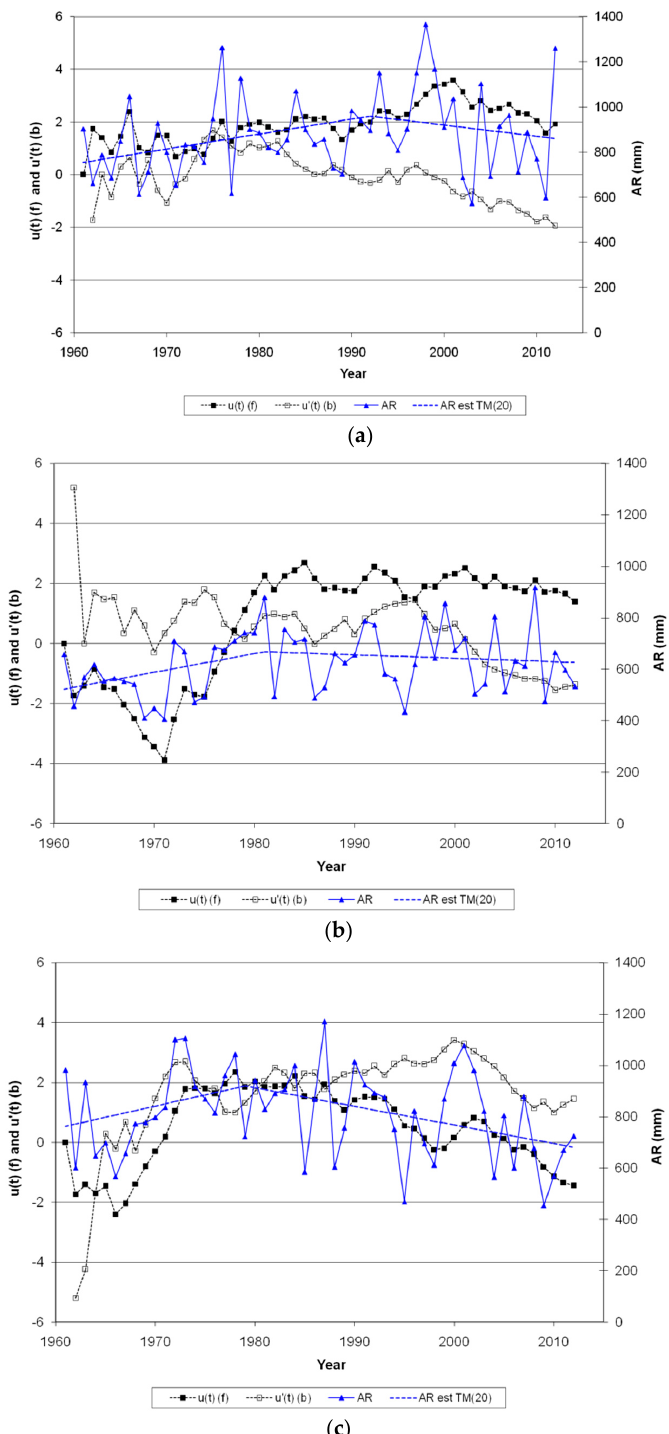
Figure 4. Annual variation of total rainfall (AR) in Laboulaye ( a ), Villa Dolores Aero ( b ), and Villa de María de Río Seco ( c ), between 1960 and 2012, and the breakpoint determination from Mann–Kendall– Sneyers, where u (t) and u’(t) are the forward (f) and backward (b) sequential test values, respectively, and from Tomé–Miranda (TM) for MINIX = 20.